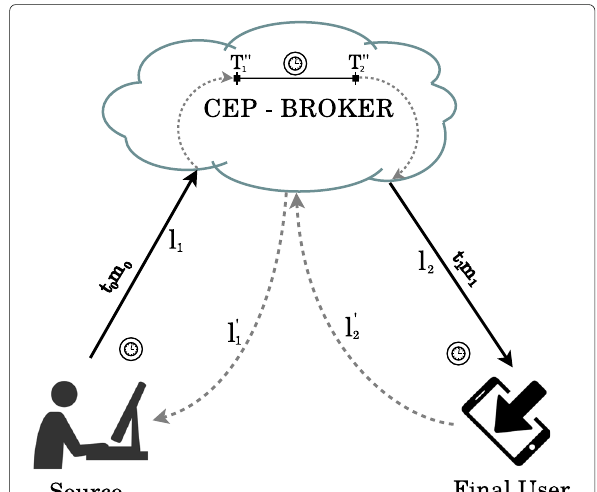
Fig. 6 Overall schema of the stress test from a Source to Final User